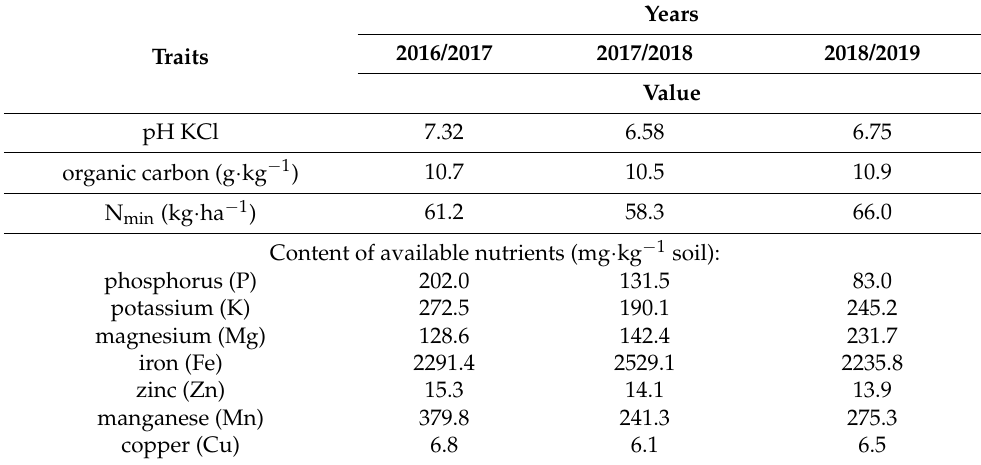
Table 2. Basic soil characteristics prior to the experiment.